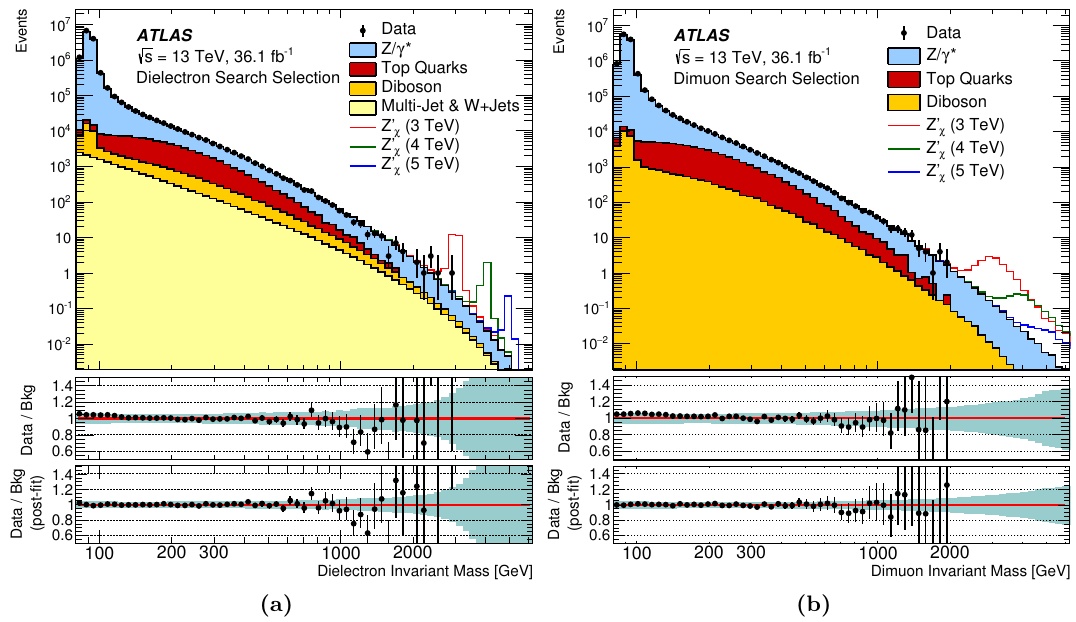
Figure 1 . Distributions of (a) dielectron and (b) dimuon reconstructed invariant mass ( m ‘‘ ) after selection, for data and the SM background estimates as well as their ratio before and after marginalisation. Selected Z 0 signals with a pole mass of 3, 4 and 5 TeV are overlaid. The bin width (cid:31) of the distributions is constant in log( m ‘‘ ) and the shaded band in the lower panels illustrates the total systematic uncertainty, as explained in section 7. The data points are shown together with their statistical uncertainty. Exact bin edges and contents are provided in table 8 and table 9 in the